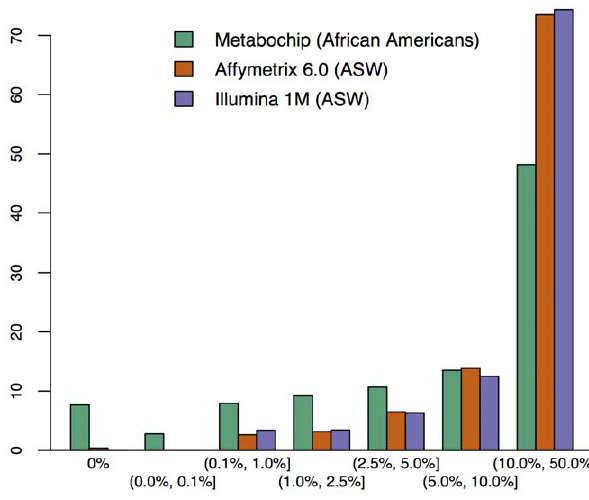
Figure 1. Distribution of minor allele frequencies on the Metabochip, the Affymetrix 6.0, and the Illumina 1 M. Intervals are open on the left and closed on the right. The Metabochip MAFs are calculated from PAGE African American samples, while the Affymetrix and Illumina GWAS array MAFs are drawn from the HapMap ASW (African ancestry in Southwest USA) population, a difference not expected to substantially impact the allele frequency distribution.